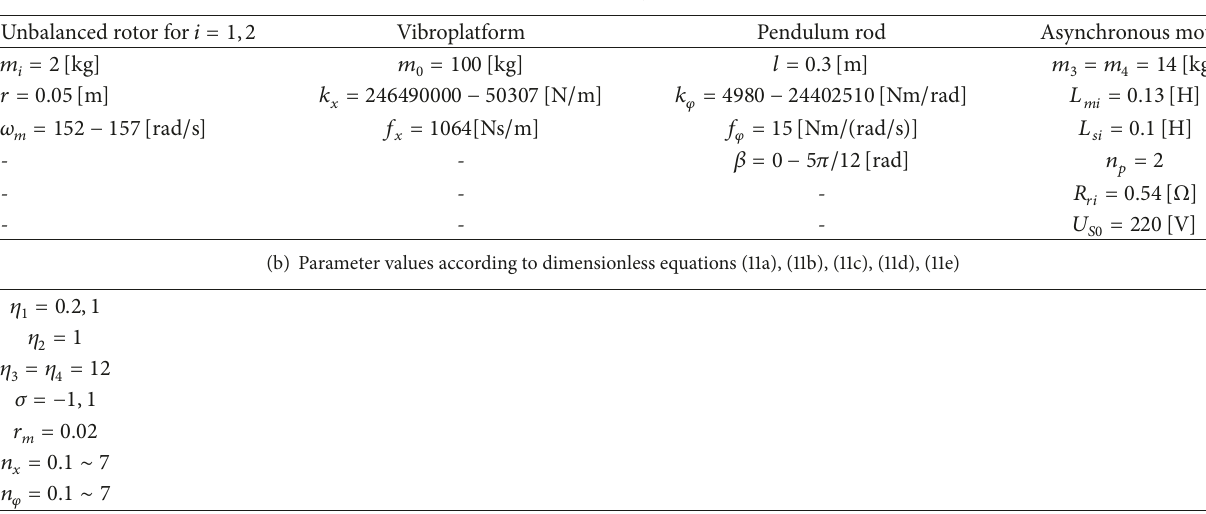
Table 1: Parameter values. (a) Parameter values for system equation